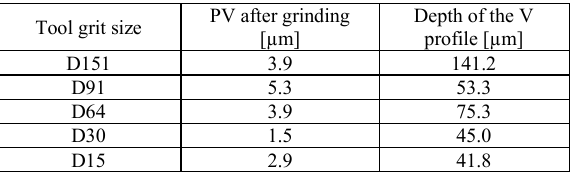
Table 4 . Surface form parameters of each smaple after grinding and plolishing.